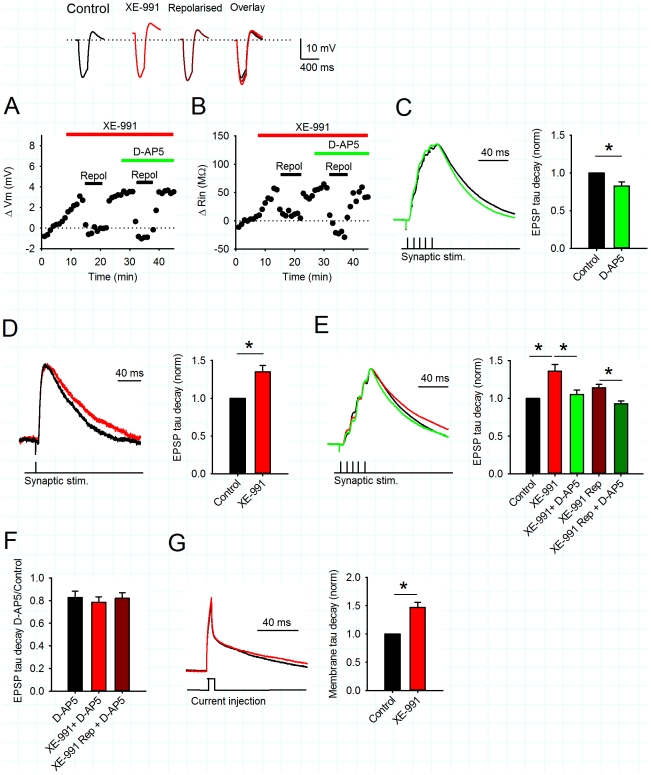
XE-991 does not enhance the NMDAR-mediated component of EPSPs.A) XE-991 (10 µM) depolarised the membrane potential and B) increased input resistance. Example voltage traces show response to a hyperpolarising current in control (black), XE-991 (red), after repolarisation and traces overlaid. Graphs illustrate the timecourse of a single experiment. C) Summated EPSPs during synaptic theta burst stimulation have a small NMDAR-mediated component. Example voltage traces show a burst of five EPSPs under control conditions (black) and in the presence of 50 µM D-AP5 (green). The average normalised decay time constant for a burst of five EPSPs is reduced in the presence of D-AP5. D) XE-991 prolonged the duration of single EPSPs. Example voltage traces in control (black) and XE-991 (red). Average decay time constants increase after application of XE-991. E) XE-991 prolonged the duration of summated EPSPs which was partially reversed either by repolarisation or application of D-AP5. Example voltage traces in control (black), XE-991 (red), XE-991 repolarised (dark red), XE-991 and D-AP5 (green) or XE-991 and D-AP5 repolarised (dark green). Average decay time constants show a partial reversal of EPSP prolongation by D-AP5 at both depolarised and repolarised potentials. F) The effect of D-AP5 on the decay time constant of summated EPSPs was similar in control conditions and in the presence of XE-991. G) XE-991 prolonged the membrane decay time constant in response to a short subthreshold current injection. Example voltage traces in control (black) or XE-991 (red). Average membrane decay time constant shows an increase in XE-991.